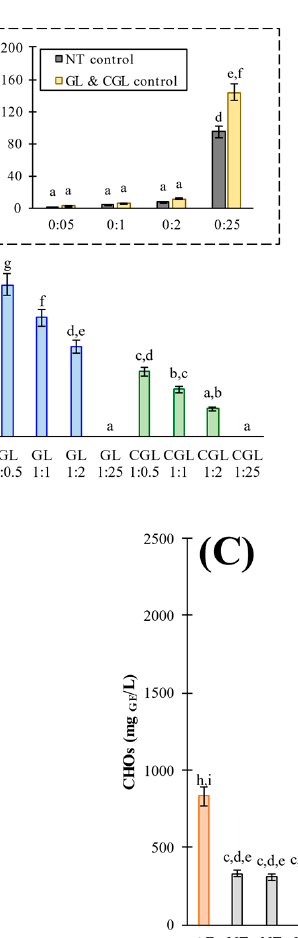
Figure 2. TPC values ( A ), sorption yields, Y P ( B ), and CHOs values ( C ) of AF ( ), CS (native ( ), and gelled ( )) control samples and AF–CS blending methods of NT ( ), GL ( ), and CGL ( ) samples. NT method: AF (seaweeds flour) and native corn starch (CS) blending; GL method: AF and gelled CS blending; CGL method: CS gelatinized in the presence of AF. Different letters indicate significant ( p < 0.05) differences among samples.